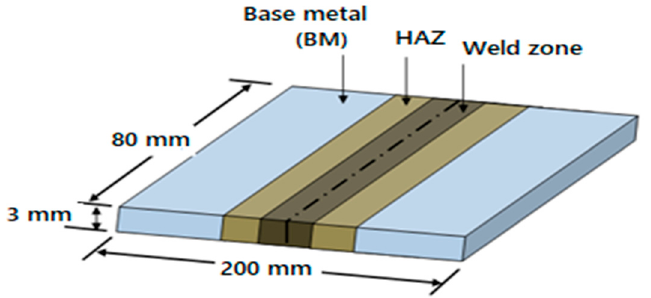
Figure 1. Weld specimen, HAZ (heat-affected zone).